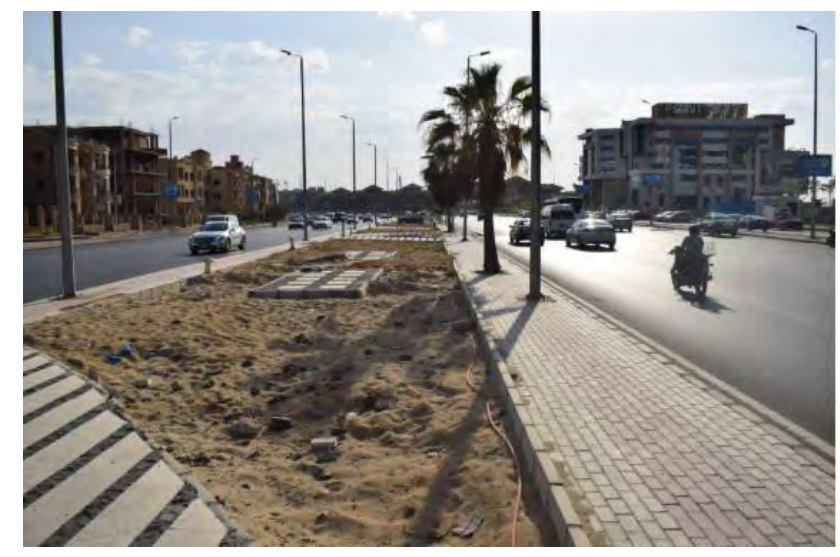
Fig. 31: Street island before proposed landscape elements.